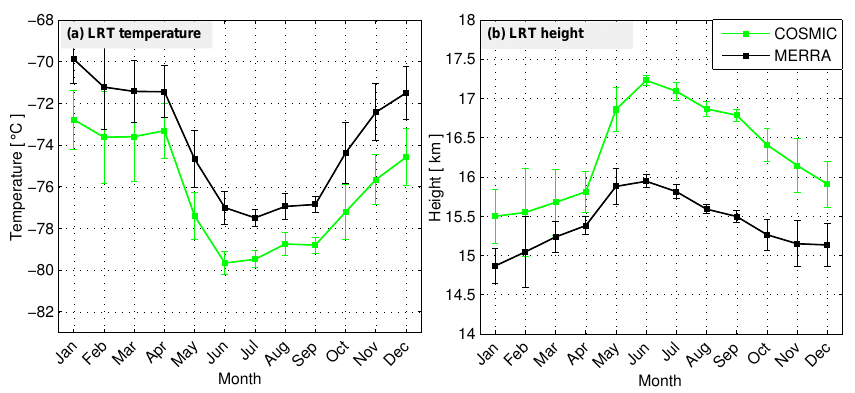
Figure 10. Annual cycle of tropopause over the GBM river basin computed from MERRA and COSMIC RO data for the period between August 2006 and December 2013: (a) tropopause temperatures and (b) tropopause heights.